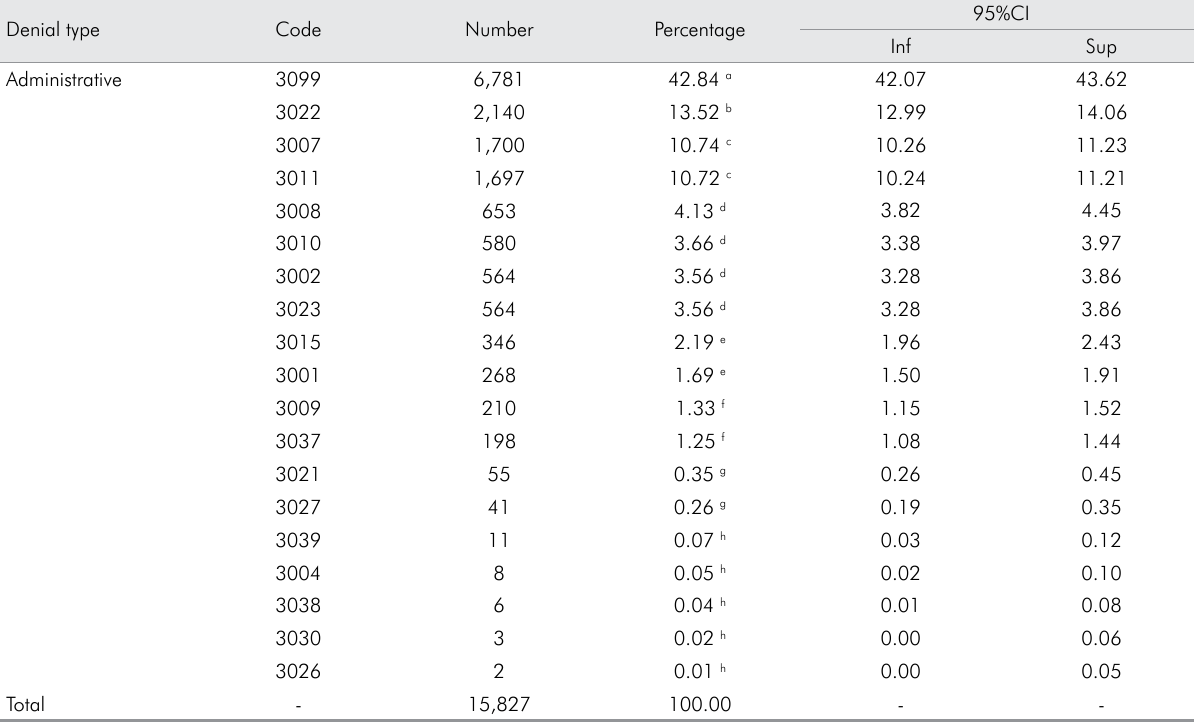
Table 3. Distribution of the administrative denial